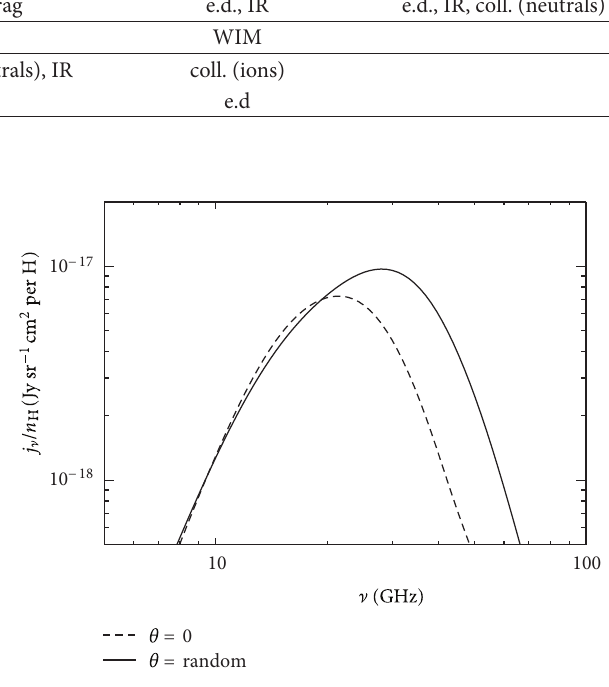
F 3: Effect of wobbling of axisymmetric grains on the spin- ning dust emissivity in the WIM environment. e spectra were produced with